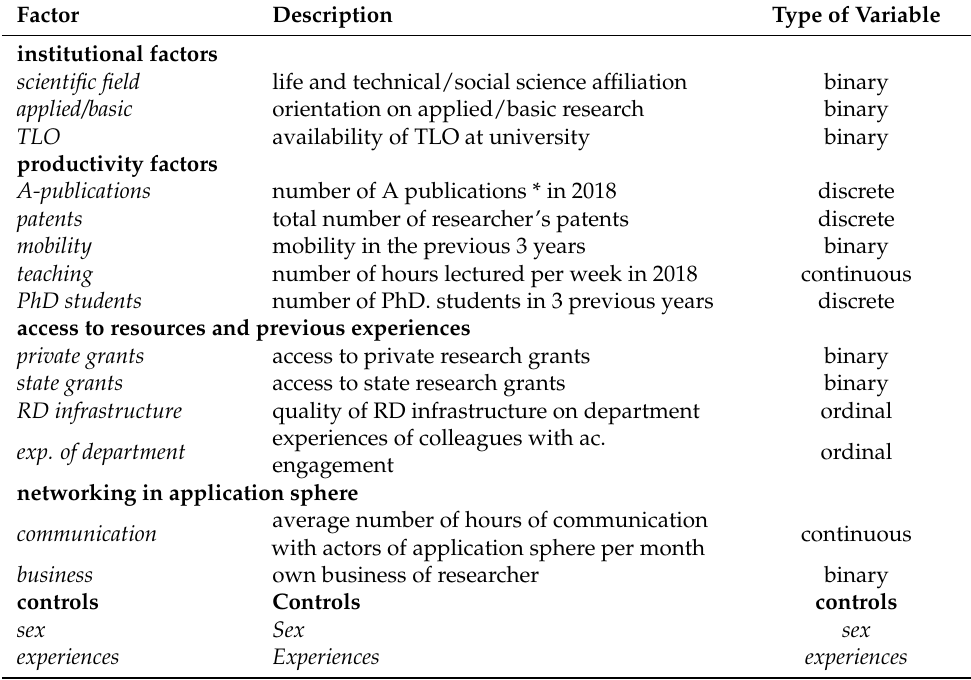
Table 1. Overview of explanatory variables in the